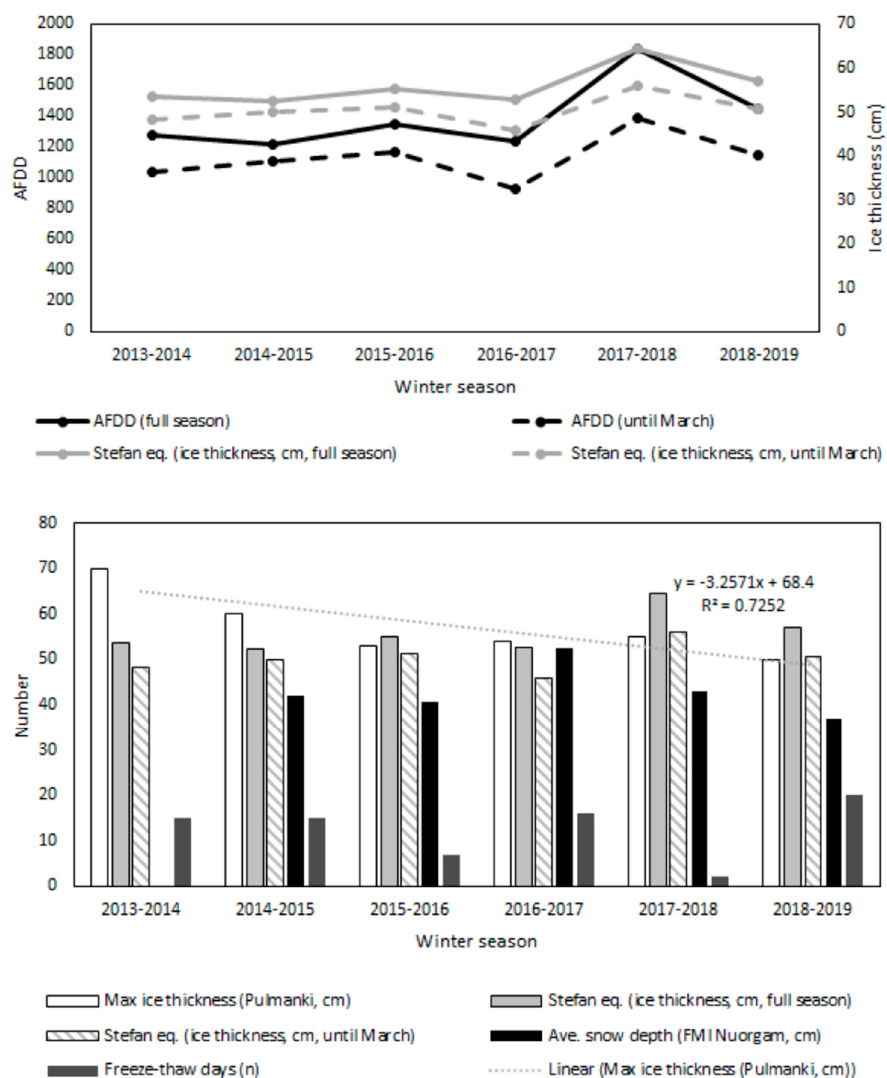
Figure 12. The results of the Stefan equation (ice thickness, cm), freeze-thaw days (number) and AFDD (degree Celsius). The Stefan equation was calculated based on the whole winter season and until March. Average snow depth was calculated from December to February.